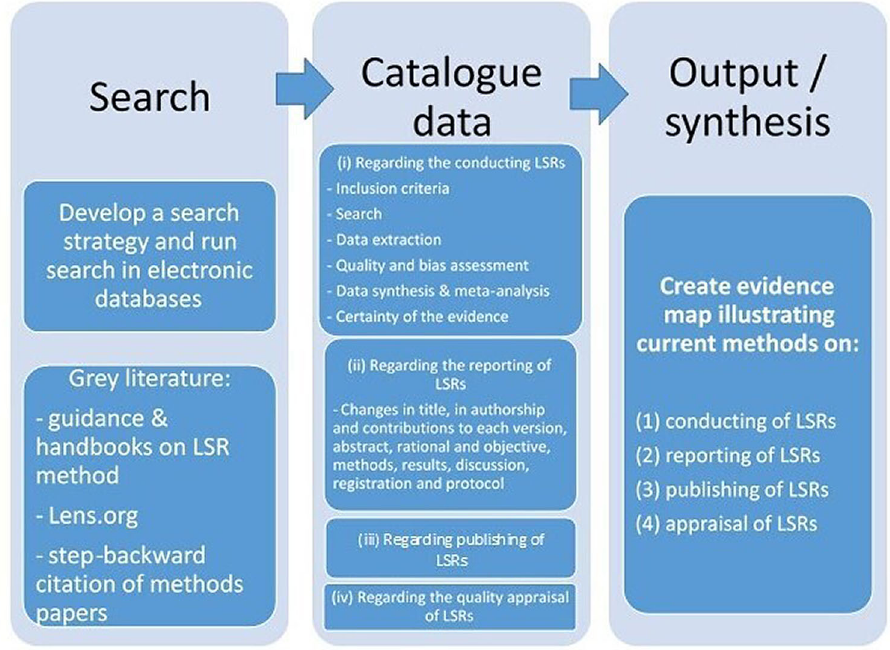
Figure 1. Framework on the methodological plan, from search to data synthesis, for this scoping